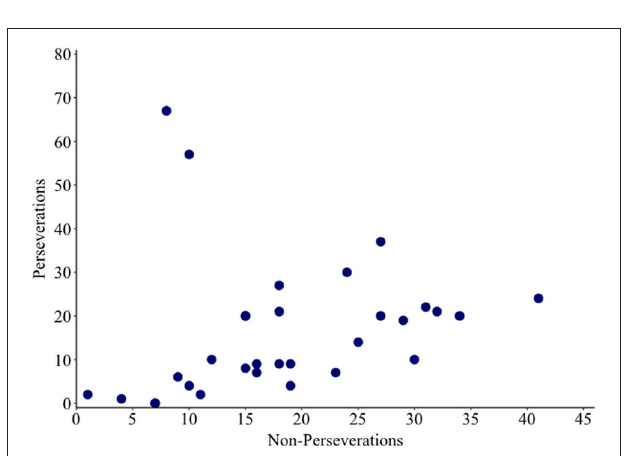
FIGURE 4 | Scatter plot showing the relationship between numbers of perseverative and non-perseverative non-words.